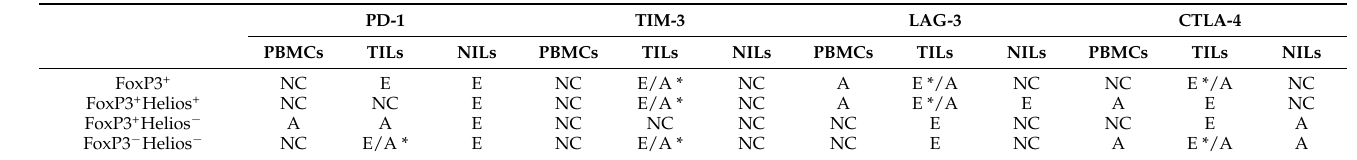
Table 1. Summary of the significant correlations between different CD4 + Treg/T cell subsets and ICs expression in early and advanced